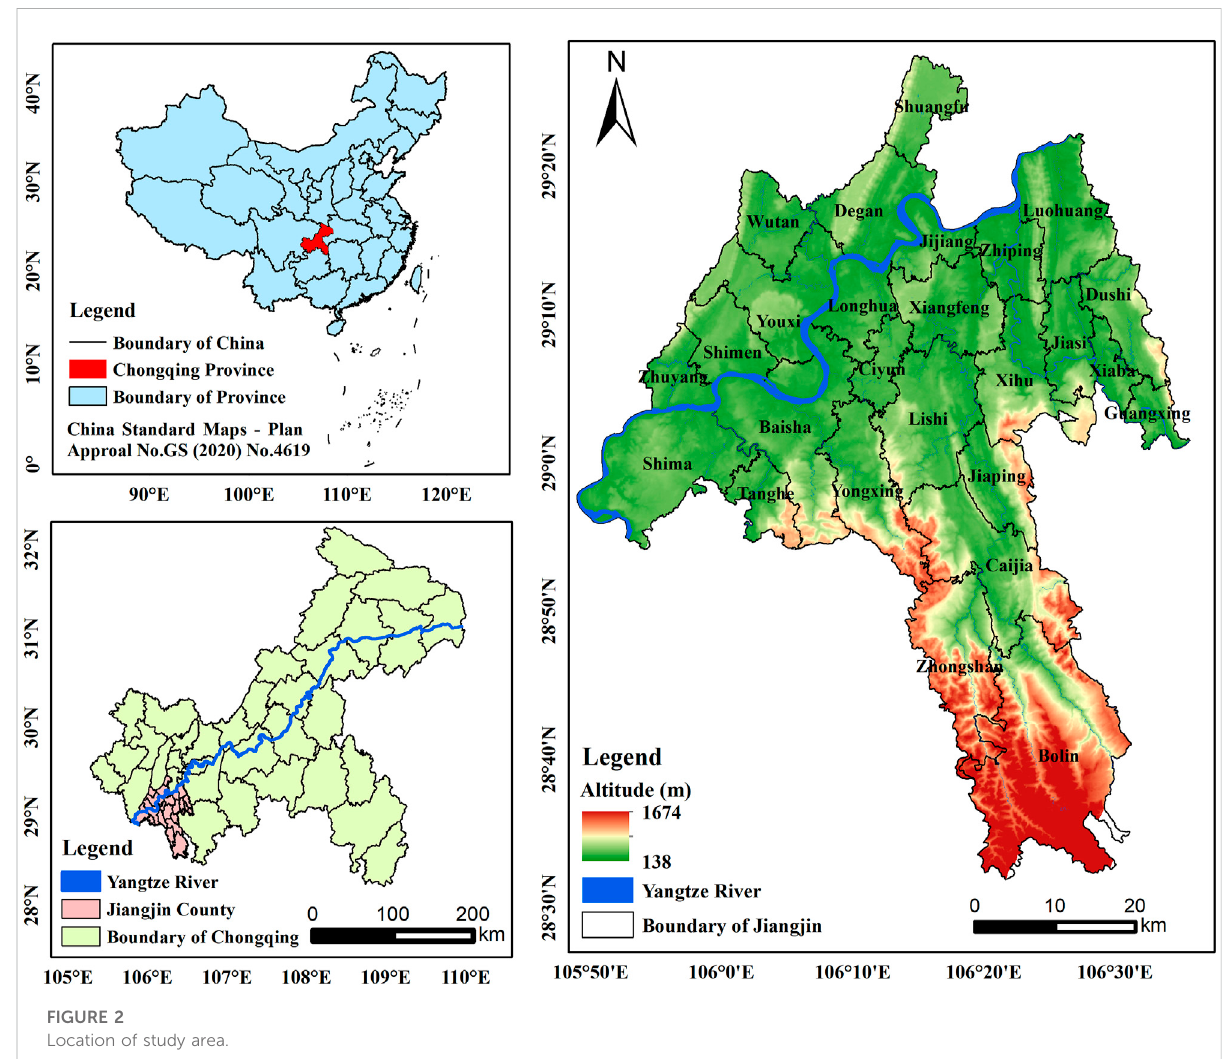
FIGURE 2 Location of study